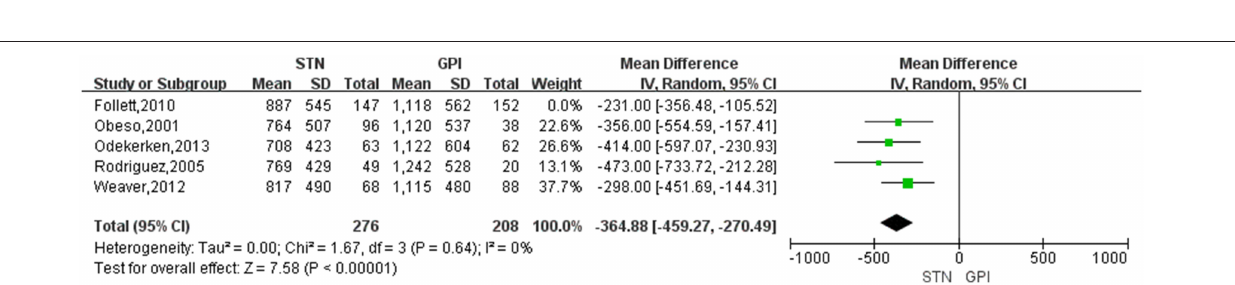
FIGURE 6 | Forest plot: sensitivity analysis. GPi, globus pallidus interna; STN, subthalamic nucleus; IV, inverse variance; CI, confidence interval.